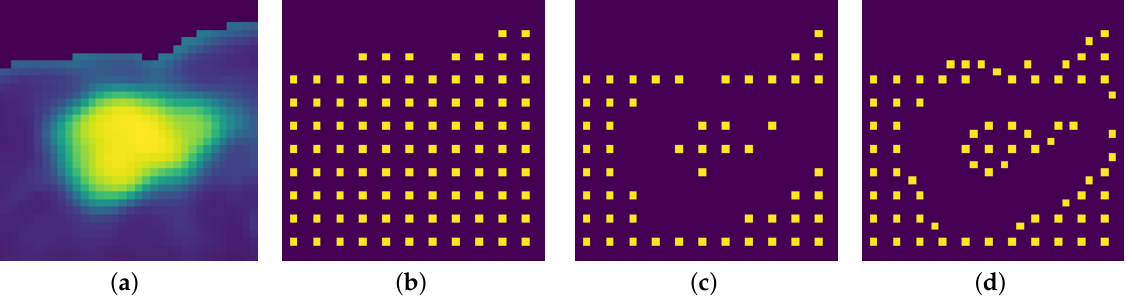
Figure 3. A seed grid generation example. ( a ) Input image. ( b ) Initial equidistant seed grid. ( c ) Seed grid after only deletion of points with high local gradient mean. ( d ) Seed grid after shifting and